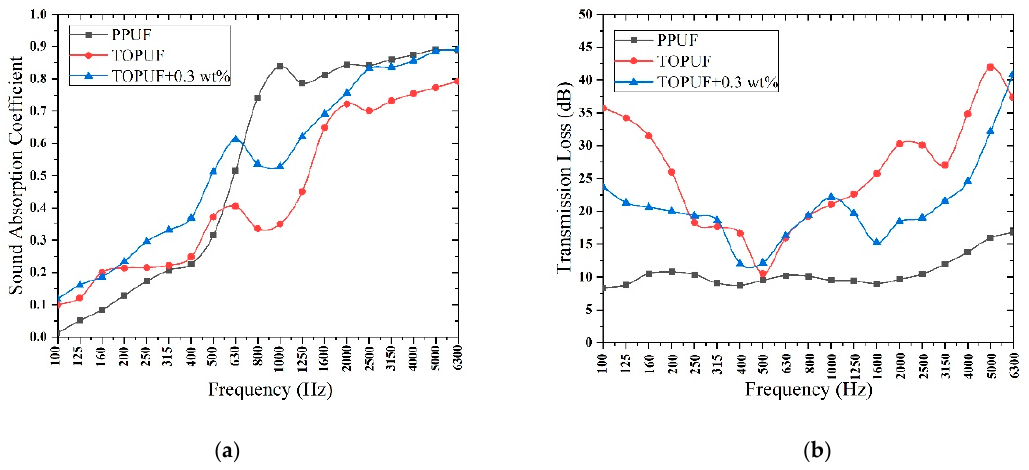
Figure 14. Comparison of sound absorption coe ffi cient ( a ) and transmission loss ( b ) between di ff erent